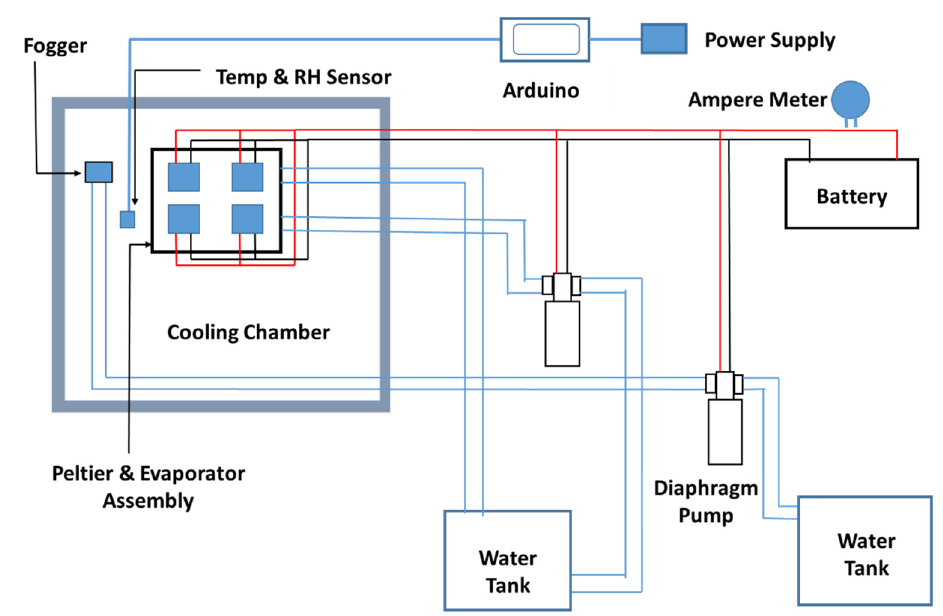
Figure 2. Schematic diagram of the component’s assembly of the thermoelectric refrigerator.